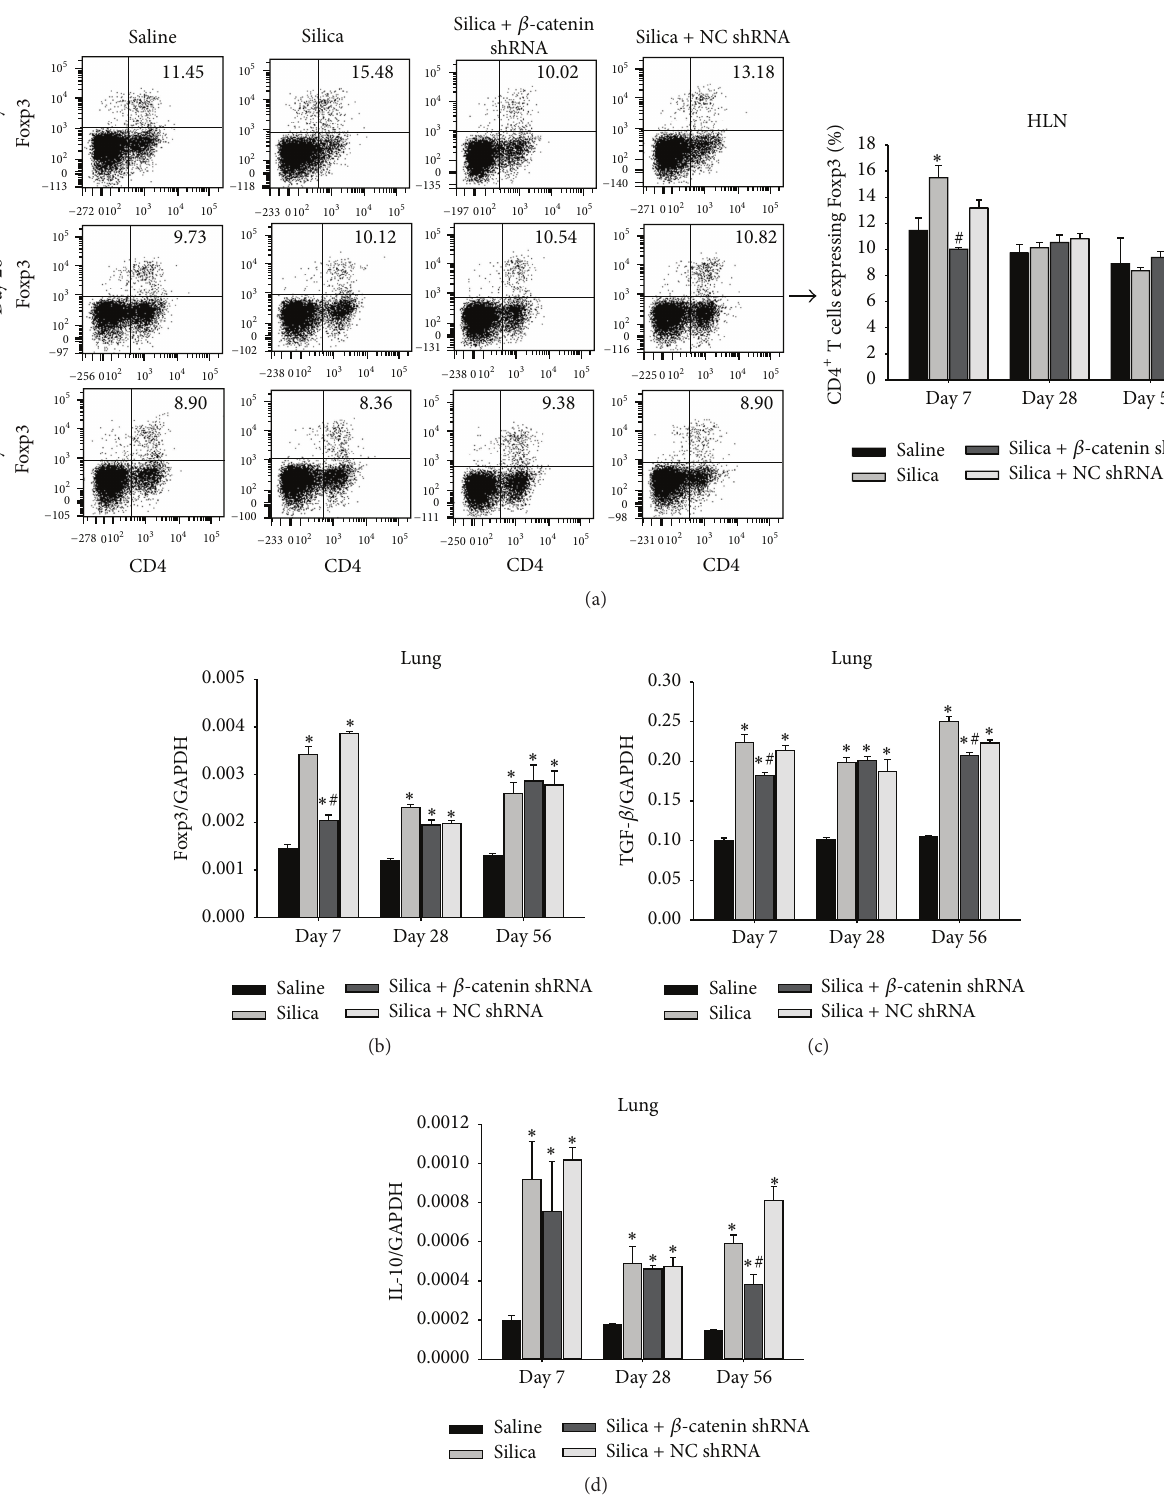
Figure 6: Blockade of Wnt/ 𝛽 -catenin pathway impaired Tregs. (a) The percentage of Foxp3 + CD4 + T cells in HLN was calculated by flow cytometry; data were shown as scatter plot and graph. Expressions of Foxp3 (b), TGF- 𝛽 (c), and IL-10 (d) in lung were assayed by real-time RT-PCR using the −ΔΔ Ct method. Values are shown as mean ± SEM ( 𝑛 = 3 –5) ( ∗ , as compared with saline group at the same time point, 𝑝 < 0.05 ; #, as compared with silica group and silica + NC shRNA group at the same time point, 𝑝 < 0.05